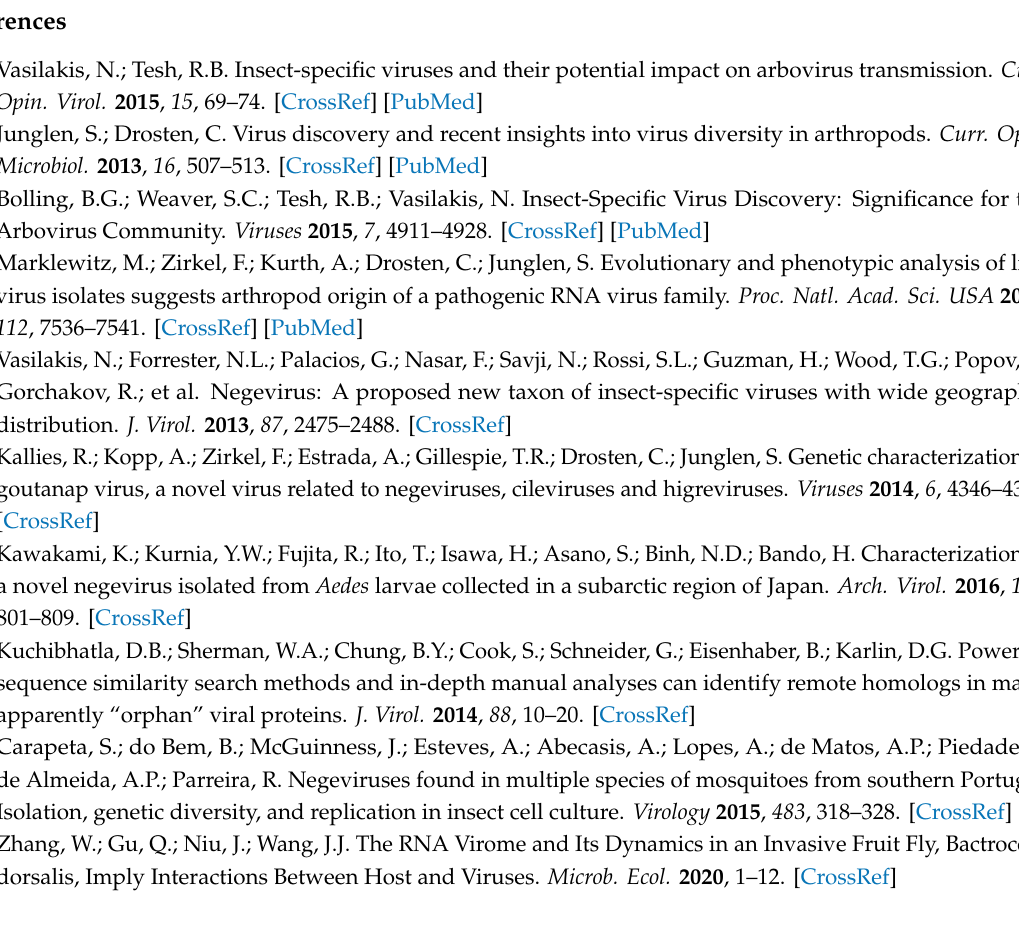
Representative negeviruses used for the identification of nege-like viral contigs; Table S2: Primers used in this